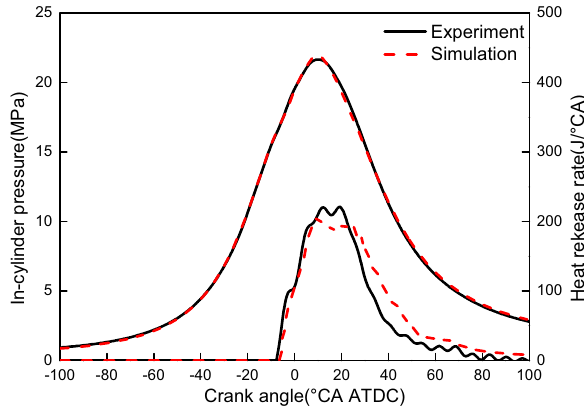
Figure 7: Comparison of experimental and numerical results of in - cylinder pressure traces and heat release rates.